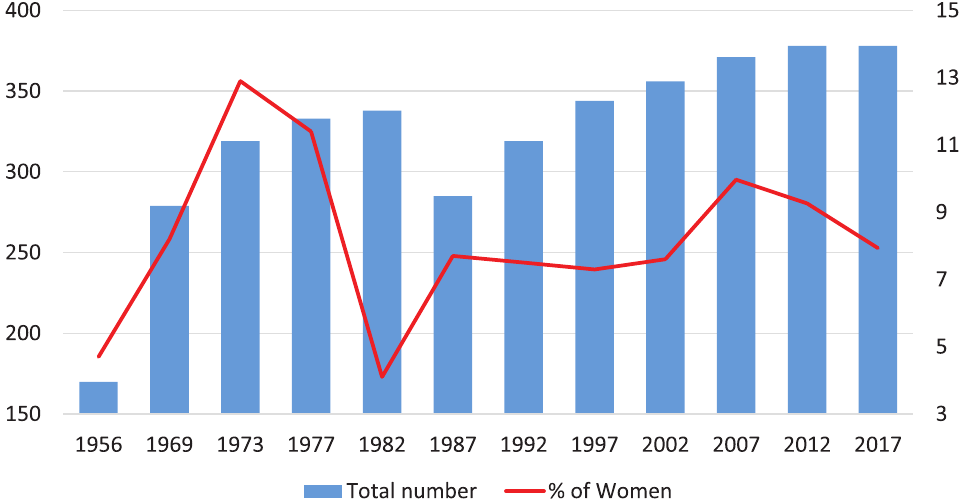
Figure 5. The number and percent of female member in the CCCPC: China 1956–2017. Sources: NSB (2012, Table 7–1) and “List of members of the 19th Central Committee” (2017) for the 2017